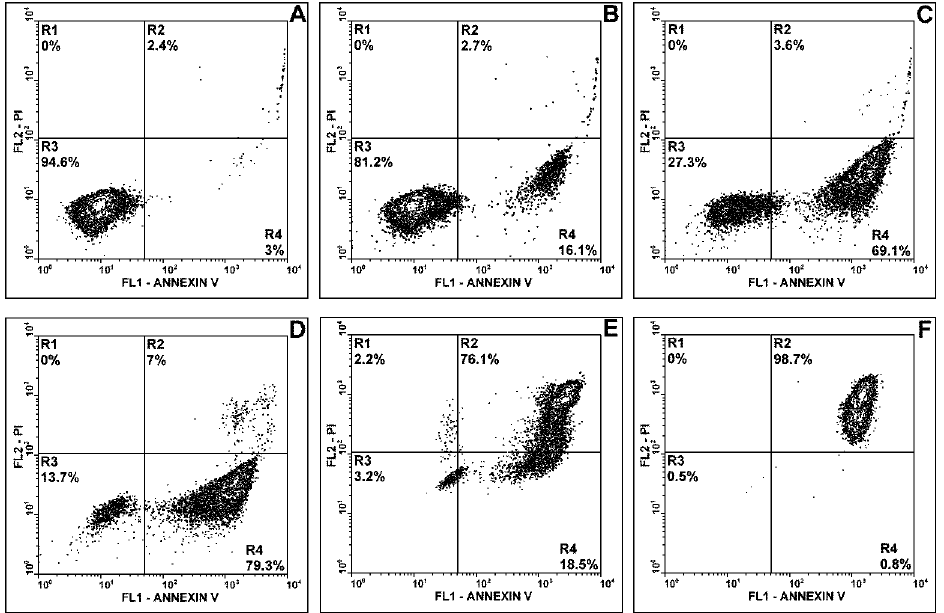
Fig. 8. Biparametric contour plots of annexin V-FITC (green fluorescence, FL1, xx 0 axis) versus propidium iodide (red fluorescence, FL2, yy 0 axis) of UV-irradiated HL60 cells. Region 1 (R1) corresponds to damaged cells (annexin-V neg /PI pos ); region 2 (R2) contains necrotic and late apoptotic cells (annexin-V pos /PI pos ); region 3 (R3) contains viable cells (annexin-V neg /PI neg ) and region 4 (R4) contains early apoptotic cells (annexin-V pos /PI neg ). A, control culture; B, C, D, E and F, cells irradiated for 3 sec, 15 sec, 5 min, 25 min and 1 h, respectively. Percentages of